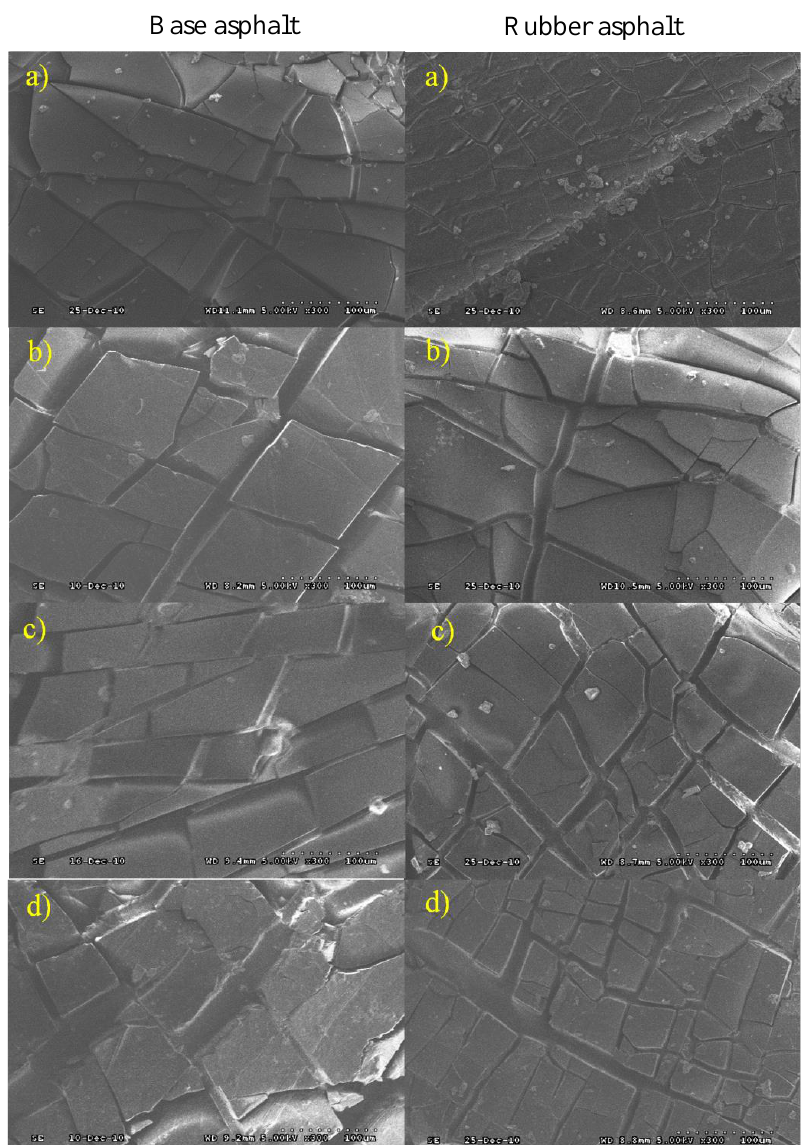
Figure 9. Appearance topography after UV aging of base asphalt and rubber asphalt in different environmental conditions (300 times): ( a ) UV; ( b ) UV + water; ( c ) UV + salt; ( d ) UV + acid.